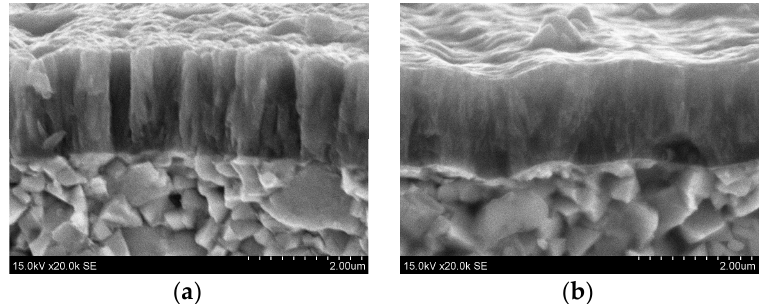
Figure 3. Breaks of hard metal WC-Co specimens with PVD coatings (×20,000): ( a ) CrN (1.83–1.89μm), ( b ) TiAlN (1.77–1.79 μm).